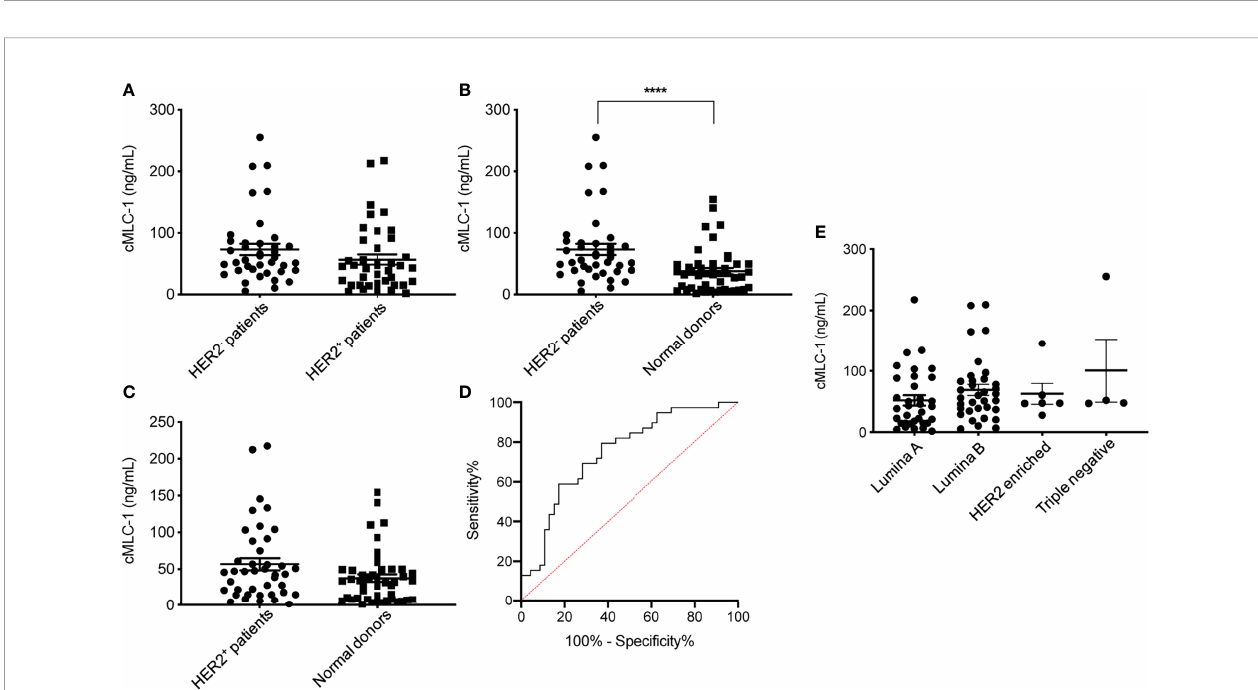
FIGURE 3 | Plasma cMLC-1 levels in HER2 - , HER2 + and different molecule subtypes of breast patients. The mean ± SD of cMLC-1 in HER2 - (n=39) vs. HER2 + (n=40) is shown ( p =0.0578) (A) . Plasma cMLC-1 was much higher in HER2 - patients than in normal donors(n=46) (**** p < 0.0001) (B) ; plasma cMLC-1 was noticeable but not signi fi cantly higher in HER2 + patients than in normal donors ( p =0.0549) (C) . The Mann-Whitney U test was used to analyze the above differences between every two groups. ROC curve analysis determined area under curve (AUC) value of the logistic regression is 0.7480 ( p <0.0001), indicating cMLC-1 at (or higher) the cutoff of 37.17 ng/mL could predict HER2 - breast cancer (D) . The means ± SD of cMLC-1 in each subtype of Luminal A (n=35), Luminal B (n=34), HER2 enriched (n=6) and triple negative (n=4) breast cancer patients were analyzed and compared using the one-way ANOVA test ( p =0.2864) (E)